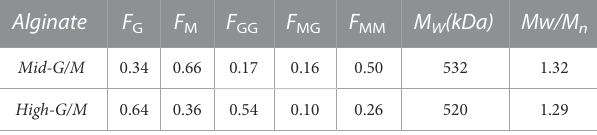
TABLE 1 Chemical composition, sequence parameters and molecularweight of the alginates used; F M , F G is the fraction of mannuronic (M) and guluronic (G) acid, respectively. The composition and segment frequencies of two mannuronic (MM), guluronic (GG) or mixed (MG) acids were determined by 1 HNMR. The mass average molecular weight (M w ) was determined by